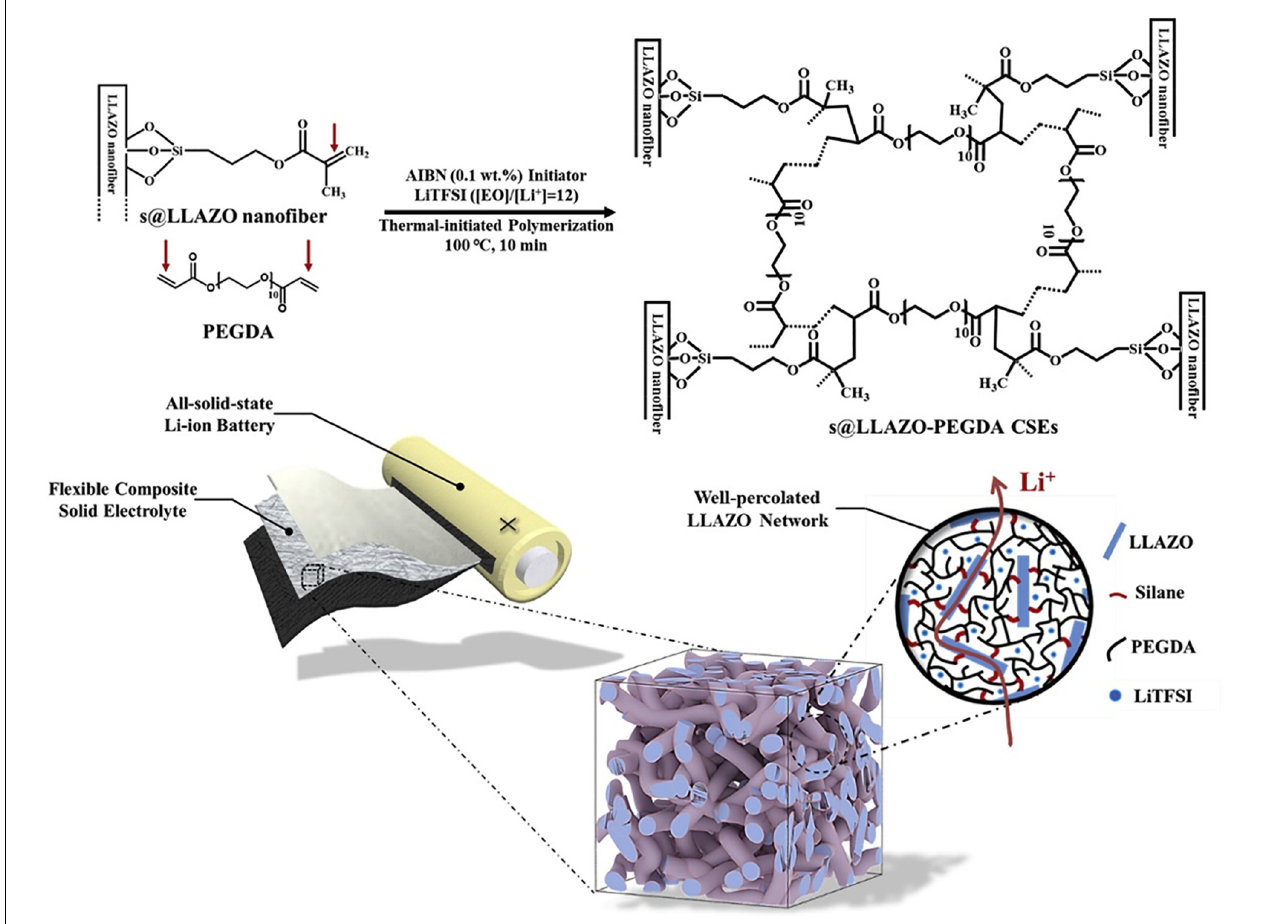
FIGURE 7 | Schematic illustration of the synthesis process of s@LLAZO-PEGDA composite solid electrolytes with percolated s@LLAZO network within the composite electrolyte. Reprinted with permission from reference Yan et al. (2020). Copyright 2020